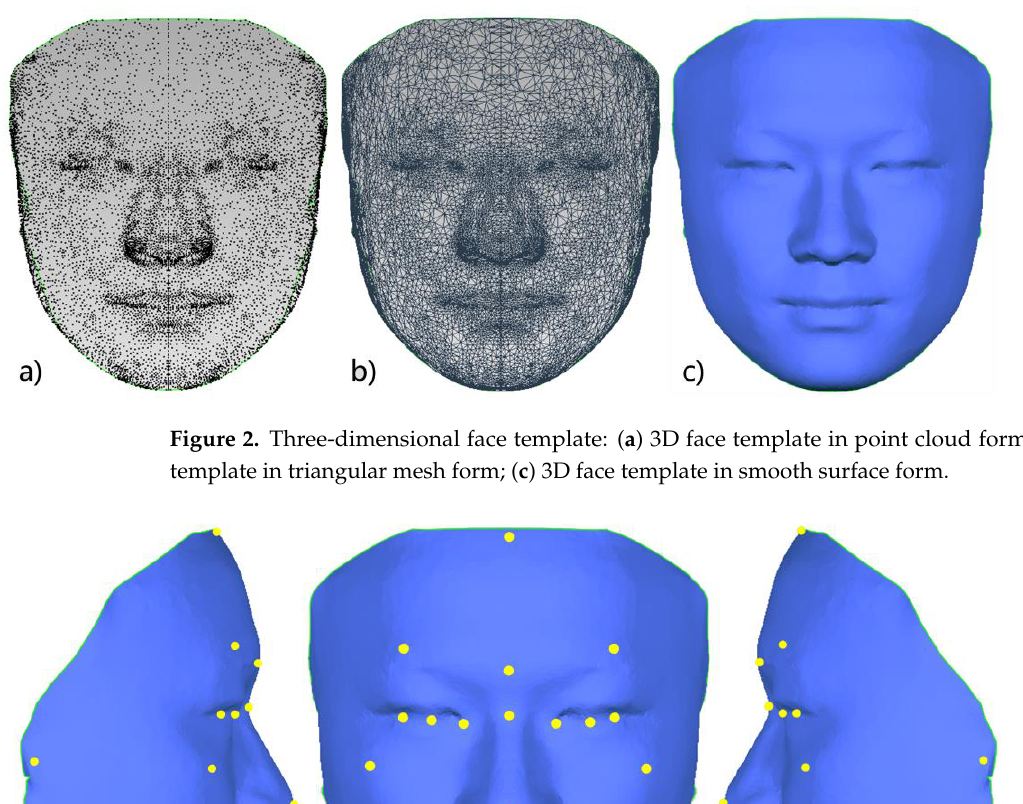
Figure 1. Flow chart depicting the experiment method.